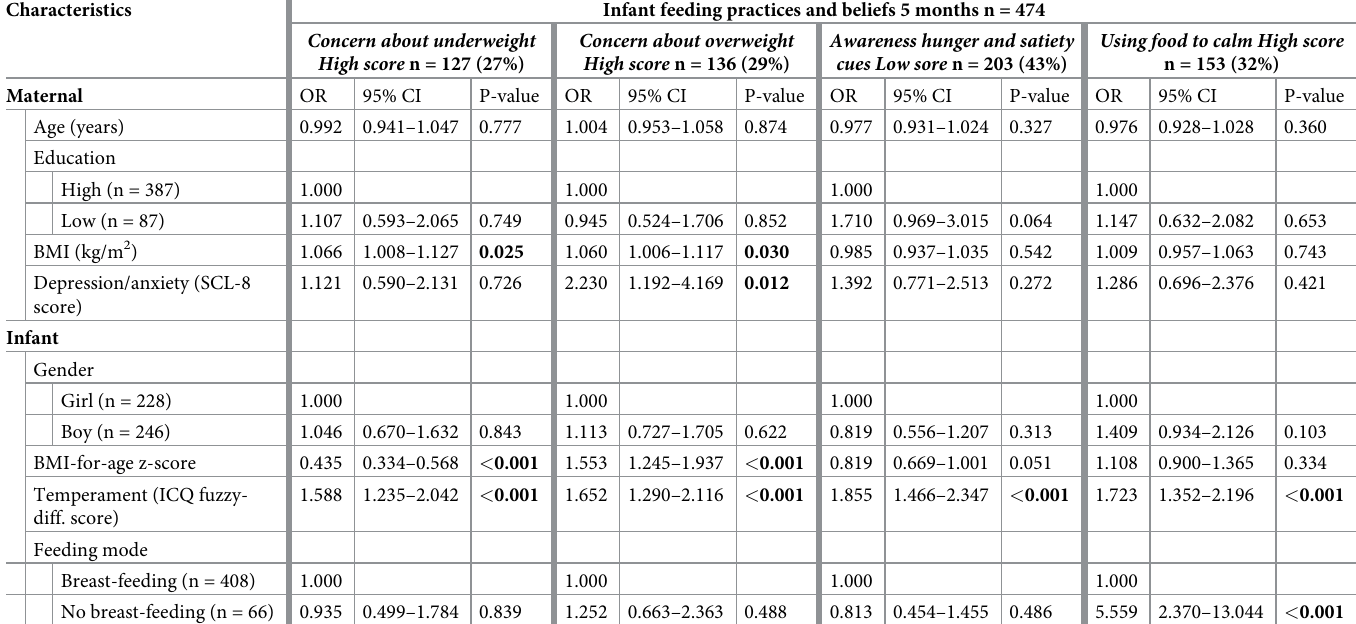
Table 2. Associations between maternal and child covariates and maternal feeding beliefs and practices at child age five months estimated by multivariable logistic regression.